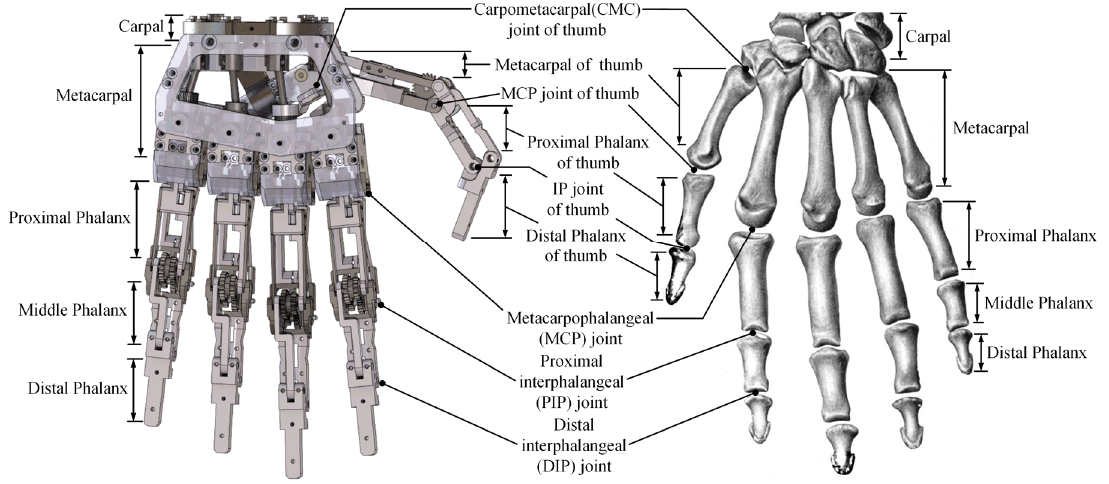
Figure 1. Skeleton structure of the human hand (right) and nomenclature of the proposed prosthetic hand (left). 70